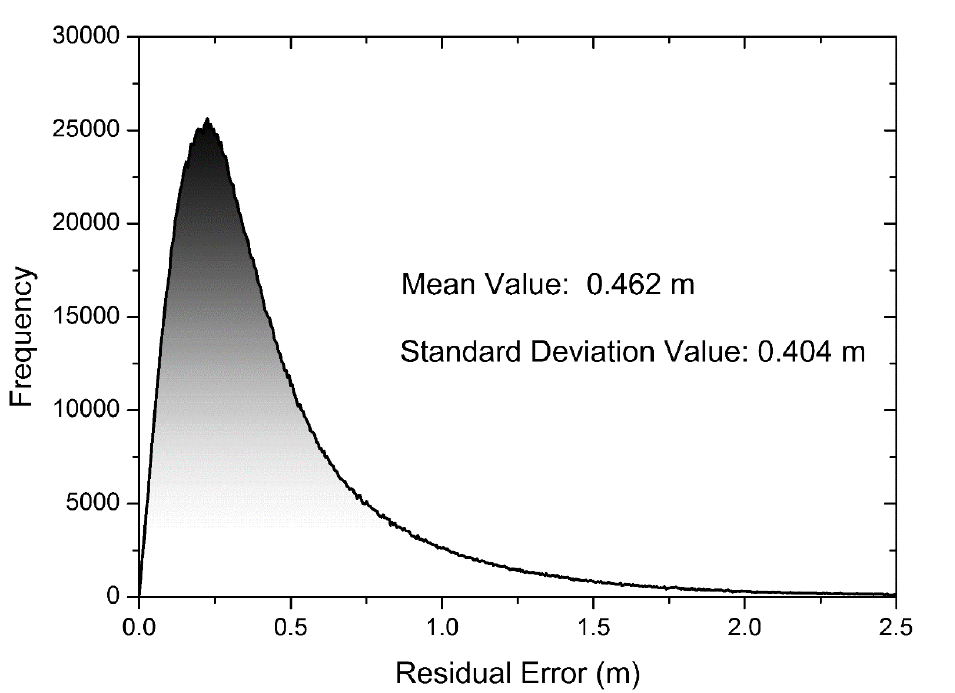
Figure 3. Histogram of residual offset values in the non-glacial